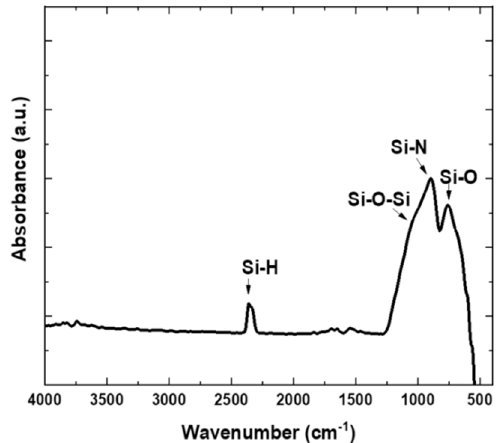
Figure 1. Fourier transform infrared (FTIR) absorbance spectra of silicon oxynitride film.